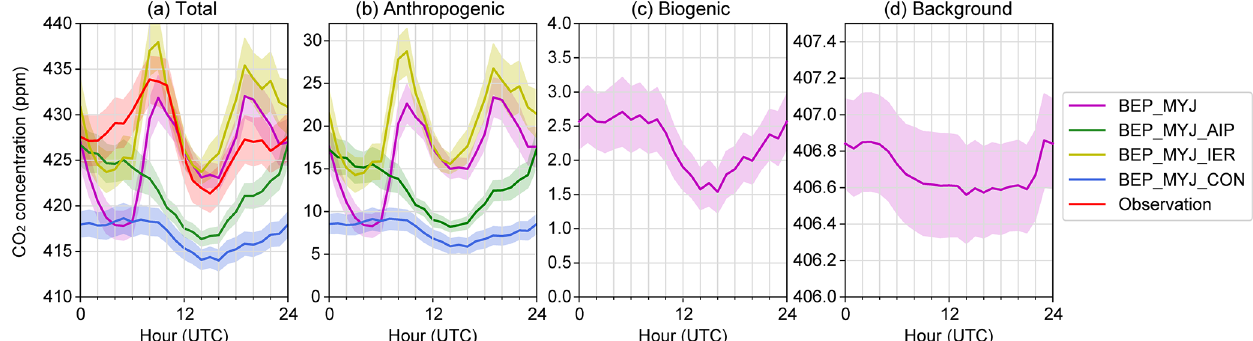
Figure 7. Average diurnal cycle of (a) total, (b) anthropogenic, (c) biogenic, and (d) background CO 2 concentrations in January for the four experiments at CDS station (Table 1b). The shaded areas extend over the standard deviation of the CO 2 concentration divided by the square root of the number of observations. BEP_MYJ is the control run using the AirParif inventory with hourly profile. BEP_MYJ_IER uses the IER inventory with hourly profile, BEP_MYJ_AIP uses a constant temporal profile (each pixel has a different emission but is constant in time based on the temporal average of the AirParif inventory). BEP_MYJ_CON uses a constant and spatially homogeneous emission where the emissions are distributed uniformly over the IdF whole